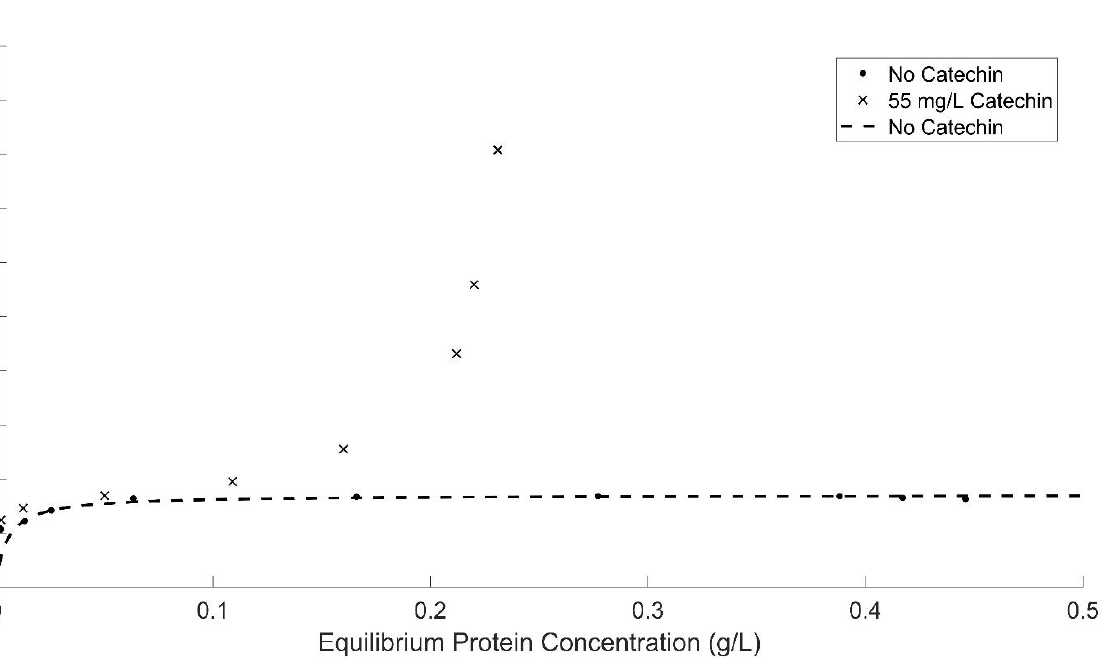
Figure 5. Macro-Prep ® ’s protein adsorption ability in model wine solutions with and without the addition of catechin by using the Bradford protein assay and UV-Vis spectrometer at 595 nm. The fit deviates from assumptions for Langmuir isotherm at high equilibrium concentrations of BSA. When fitting only the four lowest equilibrium concentrations of BSA, the adsorption capacity of Macro-Prep ® High S in the presence of catechin is about 10% lower than in the absence of catechin. A Langmuir isotherm fit with the addition of catechin is not Table 5. Effect of catechin on protein adsorption. Protein concentration was monitored by using the Bradford protein assay and UV-Vis spectrometry at 595 nm. The Langmuir isotherm parame- ters in the presence of catechin are estimated for low protein equilibrium concentrations.